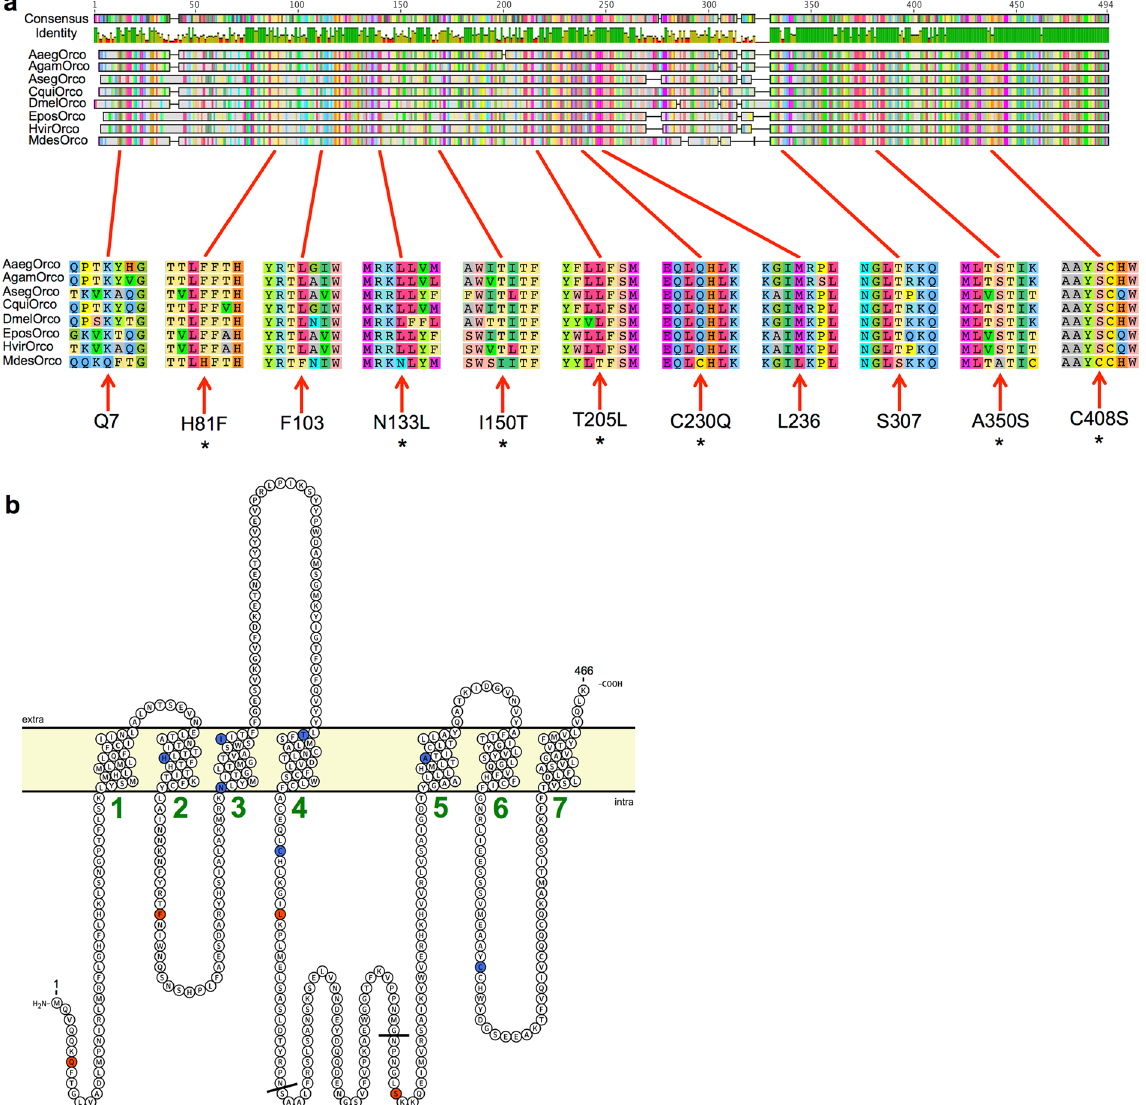
Figure 1. ( a ) MUSCLE alignment of Mayetiola destructor Orco (MdesOrco) along with VUAA1-responsive Orcos. Numbered amino acids indicate MdesOrco residues that diverge from those conserved in other Orcos. Asterisks indicate residues that were mutated in this study. Aaeg = Aedes aegypti , Agam = Anopheles gambiae , Aseg = Agrotis segetum , Cqui = Culex quinquefasciatus , Dmel = Drosophila melanogaster , Epos = Epiphyas postvittana , Hvir = Heliothis virescens . ( b) Predicted MdesOrco membrane topology using TOPCONS software 60 , visualised using Protter software 68 . Green numbers represent predicted transmembrane helices. Blue circles indicate the location of the divergent MdesOrco residues that were mutated in this study and red circles those that were not mutated in this study. Residues between black lines are part of the highly divergent IL2 region of